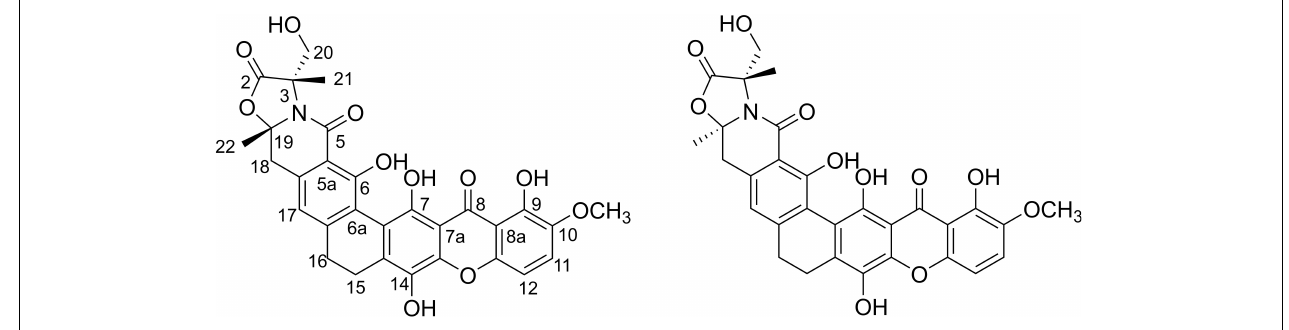
FIGURE 1 | Structures of citreamicin ε A and